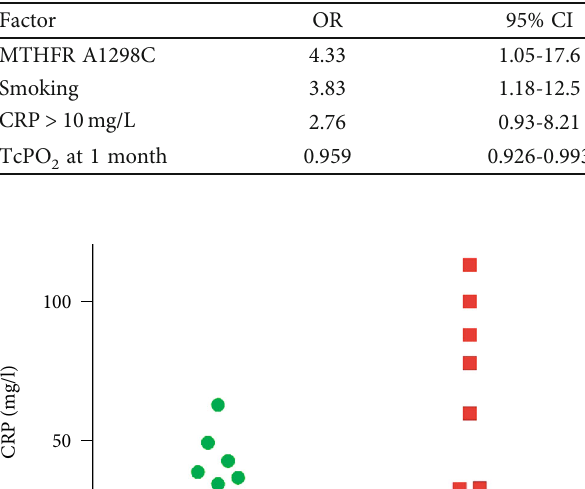
Figure 1: Time to amputation in the AMP group ( n = 37 ). Table 3: Independent predictors for major amputation.